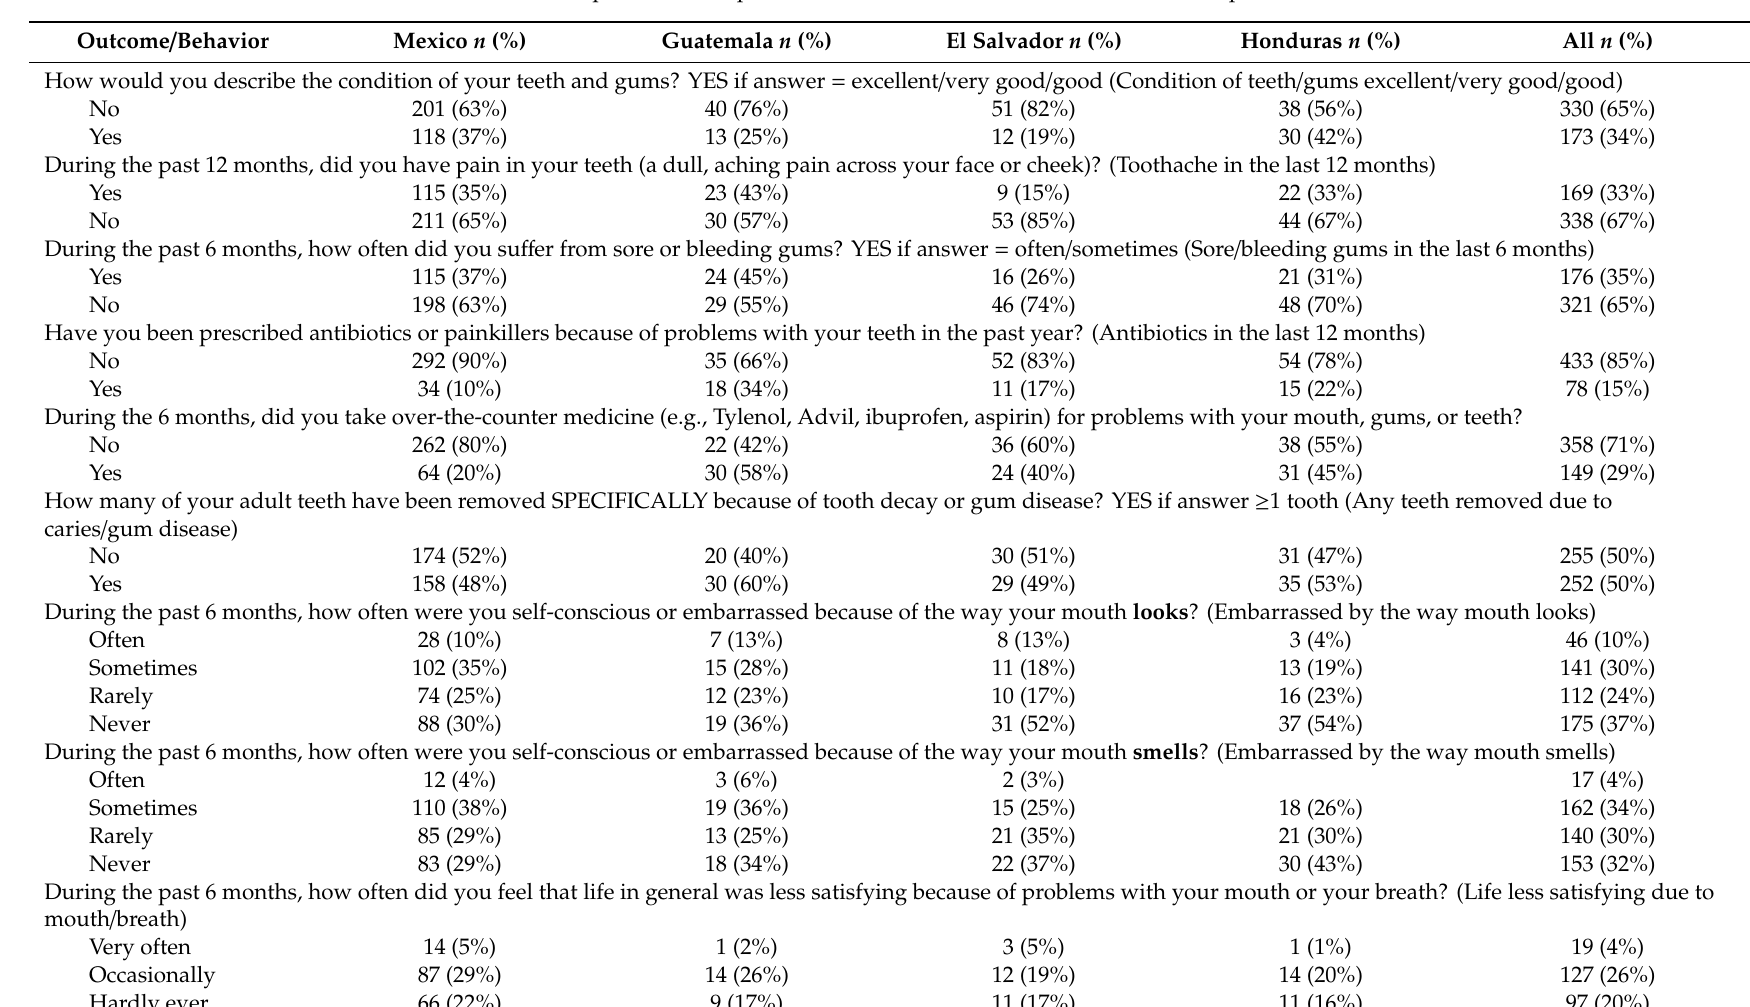
Table 1. Description of self-reported oral health-related outcomes and self-care practices